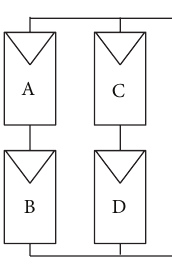
Figure 1: CF.01—the 2 × 2 SP matrix reference configuration.